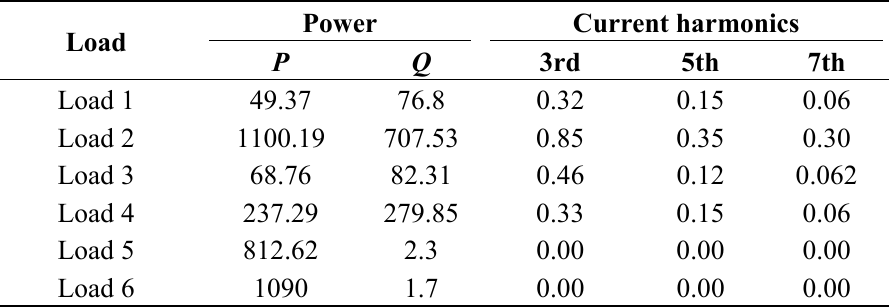
Table 5. Actual feature parameters.